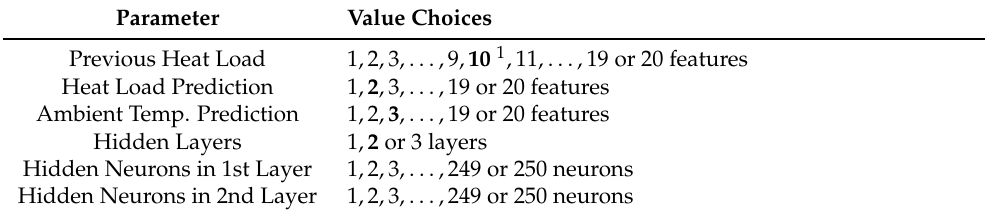
Table A4. Considered parameters and their value choices for architecture tuning.